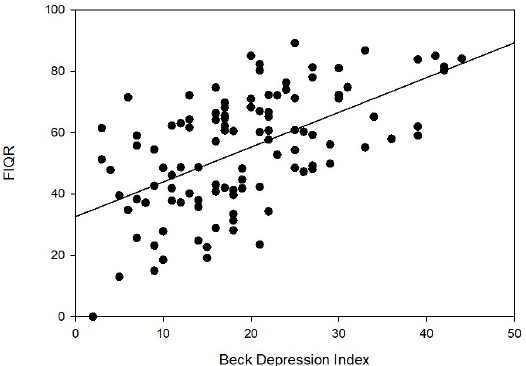
Figure 2. FIQR versus BDI for FM subjects. Pearson correlation is 0.588. Statistically significant at the 0.01 level